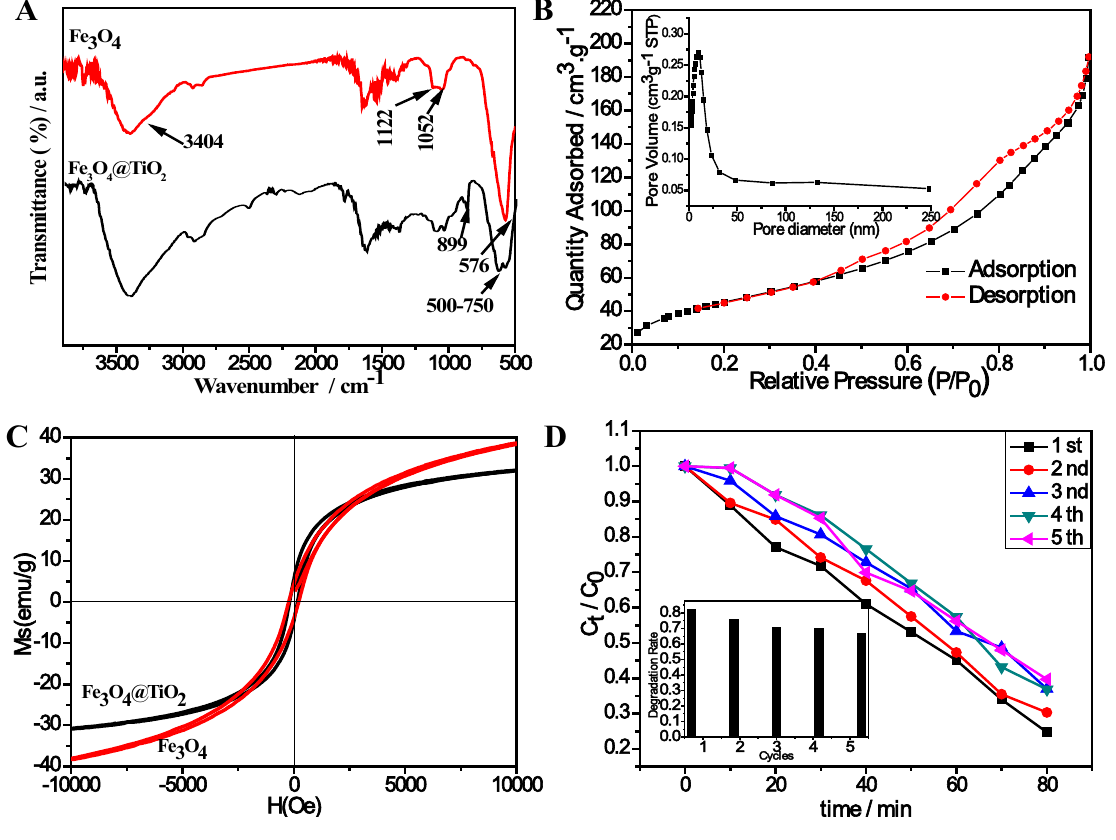
Figure 3. ( A ) FT-IR spectra of the as-made Fe nanoparticles (b); ( B ) N (inset) of the Fe Fe O . The insert is the magnetic separation photographs of Fe 3 4 absorption spectrum of the P25 and Fe band